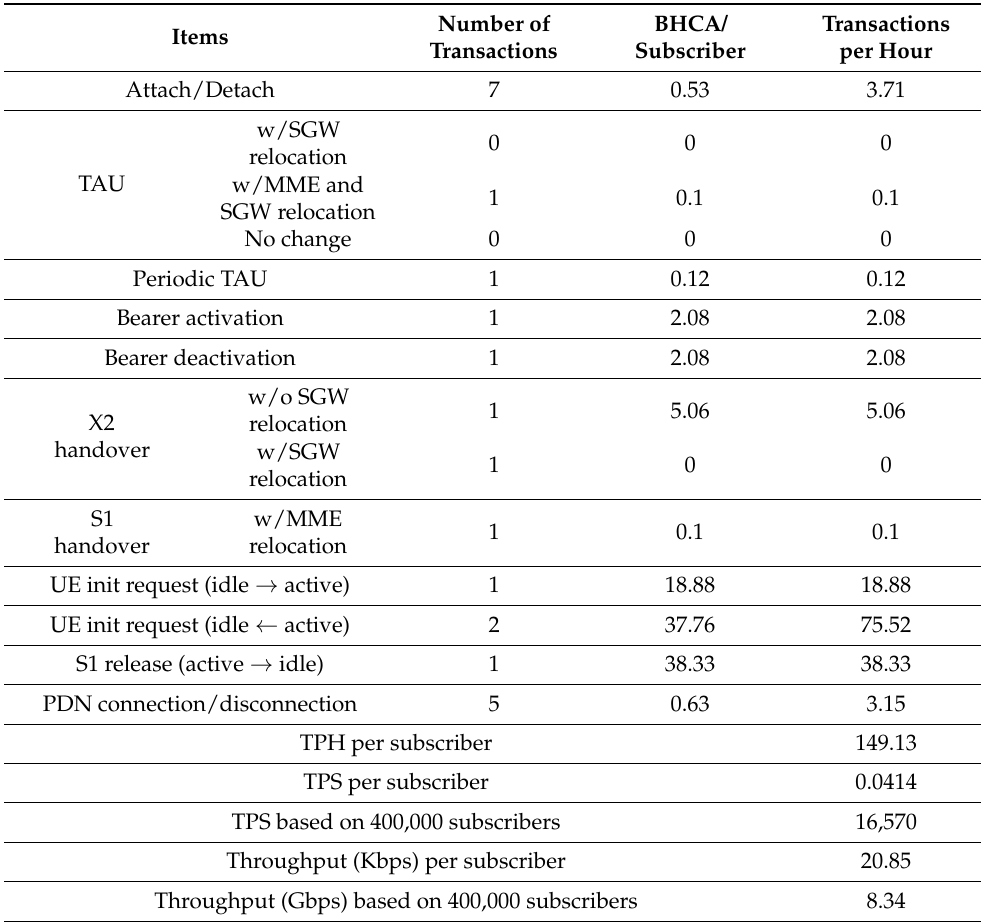
Table 3. SAE-GW call model: assuming 400,000 subscriber